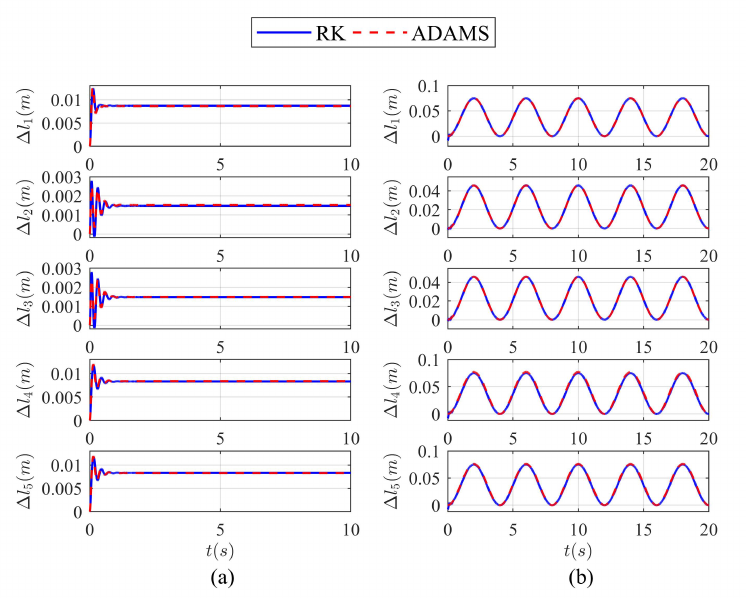
Figure 4. Comparison of the variations of L ( l 1 , l 2 , l 3 , l 4 , l 5 ) under RK method and ADAMS. ( a ) Time history plot of the variations of L ( l 1 , l 2 , l 3 , l 4 , l 5 ) under the positioning motion, and the tracking signal of the end-effector is given as x = 0, y = 0, z = − 0.55, α = 0, and β = 0. ( b ) Time history plot of the variations of L ( l 1 , l 2 , l 3 , l 4 , l 5 ) under the periodic motion, and the tracking signal of the